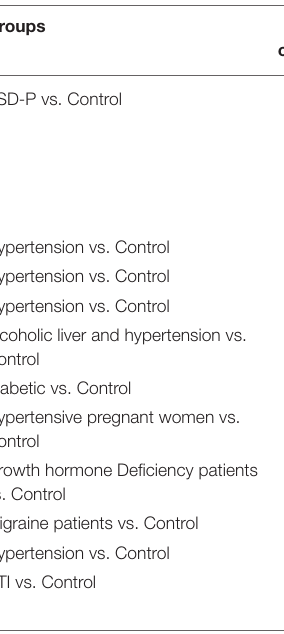
TABLE 1 | Summary of urinary NO x , NO x /CREA, and NO − 2 /NO − 3 among